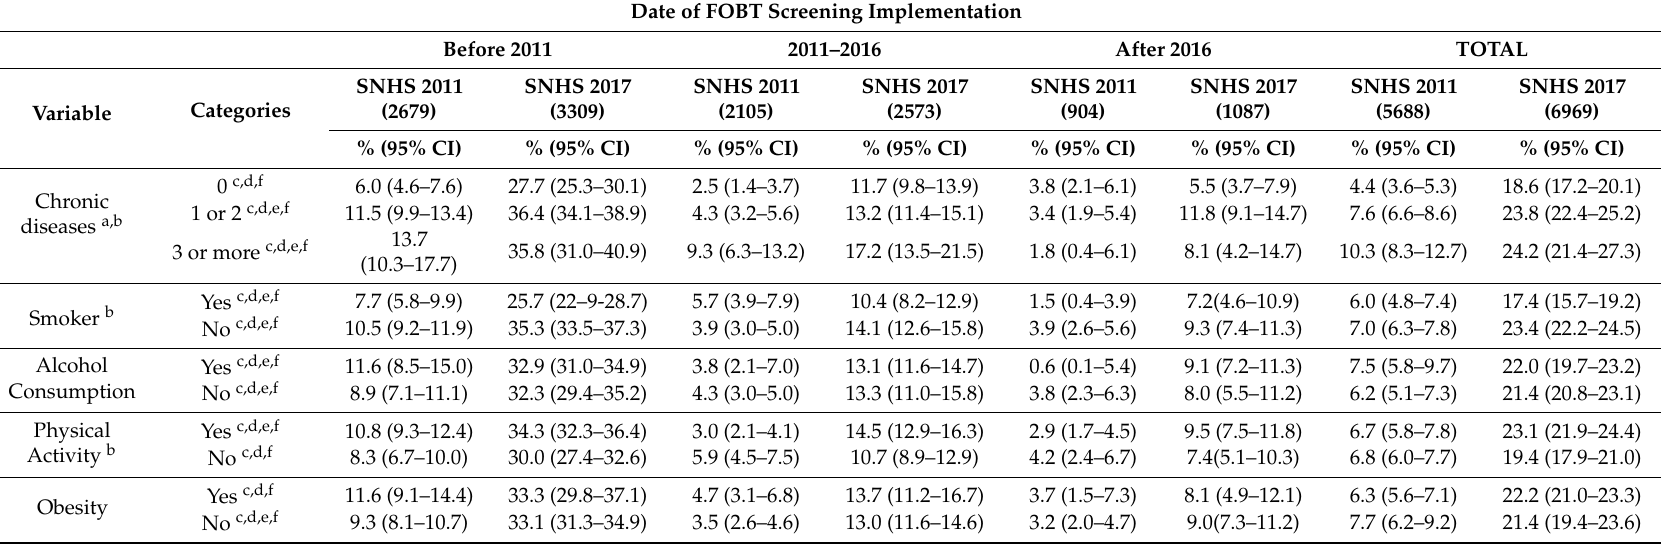
Table 4. Uptake for the fecal occult blood test in the past two years among the target population by health status and lifestyle variables and according to the FOBT implementation date. Results from the Spanish National Health Surveys 2011 and